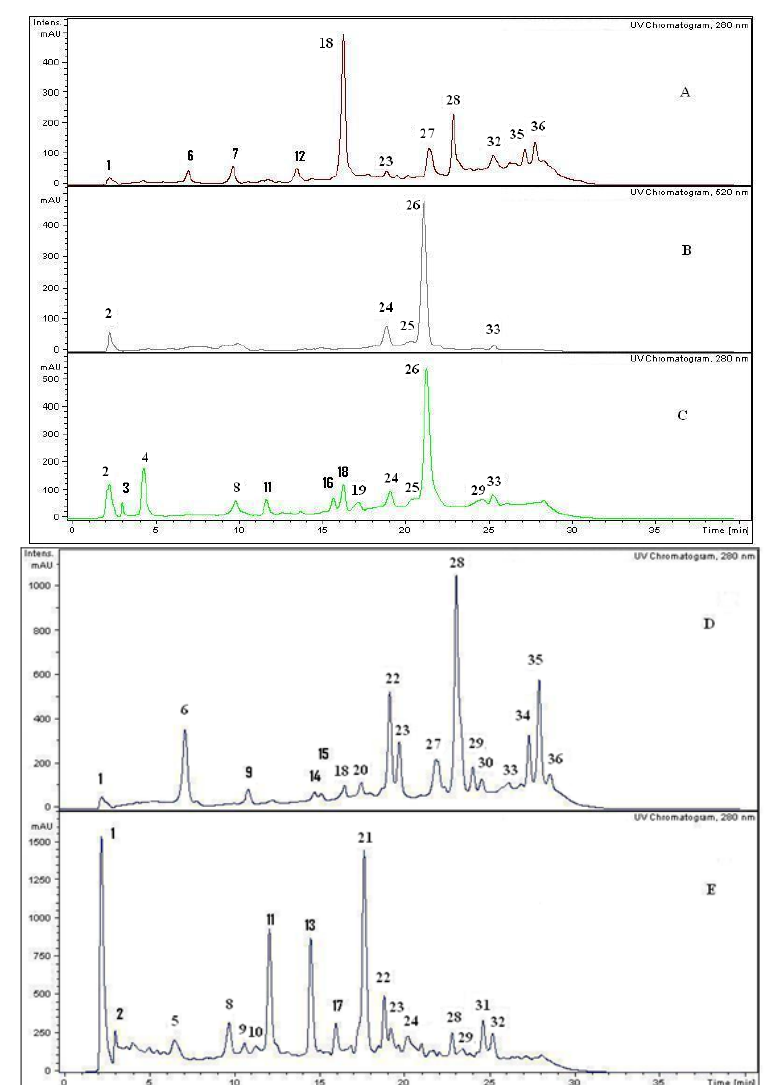
Figure 2. HPLC–DAD chromatograms at 280 nm of the MeOH extracts of: A : C.